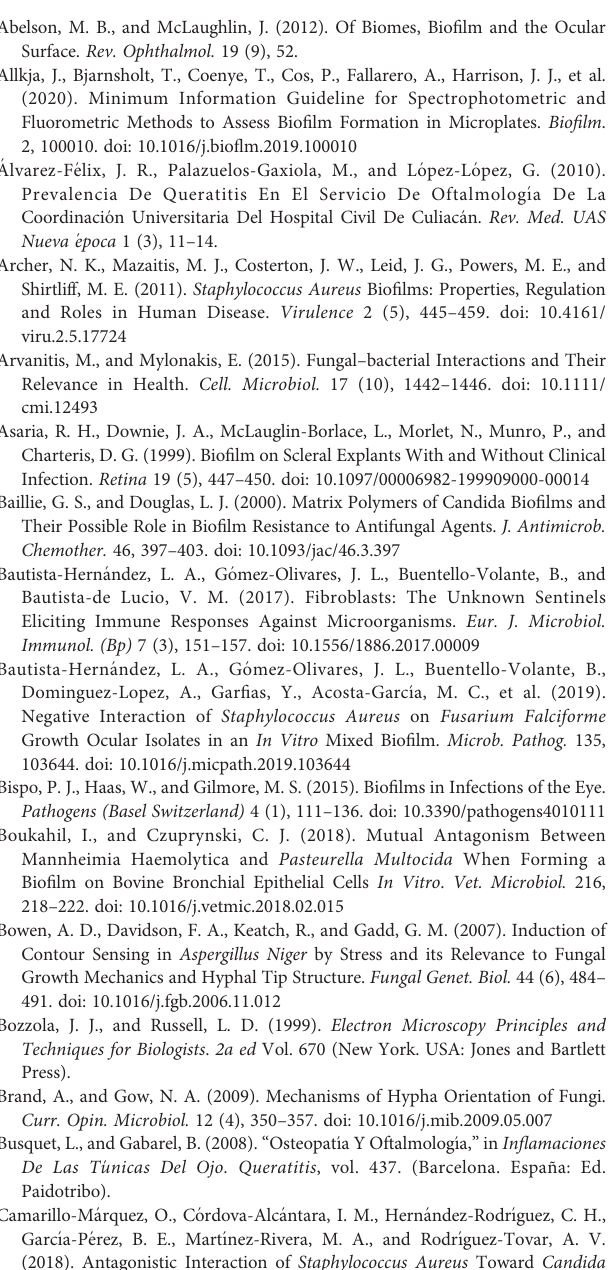
Supplementary Figure 4 | Behavior of HLFC during FBI observed by TEM at 24 h. Intracellular cocci dividing (presence of bacterial septum) a crescent formation is distinguished ( A : 20000x; B : 20000x). Cocci surrounded deformed hyphae ( C : 15000x). Zooming permitted to observe desmosomes ( D : 40000x). AF infection caused heterogeneous cytoplasm and adjacent microvesicles to the cytoplasmic membrane of HLFC ( E : 7500x; F : 20000x); hyphae perforate the cytoplasmic membrane. HLFC, Human Limbo-Corneal Fibroblasts; AF, Aspergillus fumigatus ; SA, Staphylococcus aureus ; H, hypha; F, Fibroblast; M, Cytoplasmic membrane; Nm, Nuclear membrane; N, Nucleus; Nc, Nucleolus; Eps, Exopolymeric substance; Cc, Cocci; Bg, Interstitial; Bs, Bacterial septum; Mv, Microvesicles; Cf, Crescent formation; D,